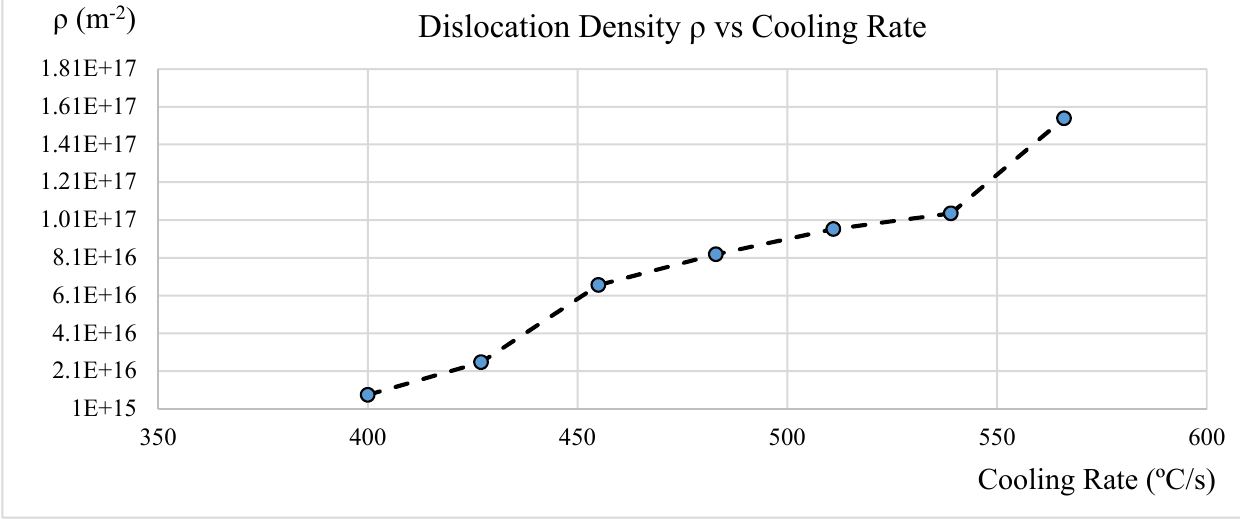
Figure 8. Cooling rate and average dislocation density .